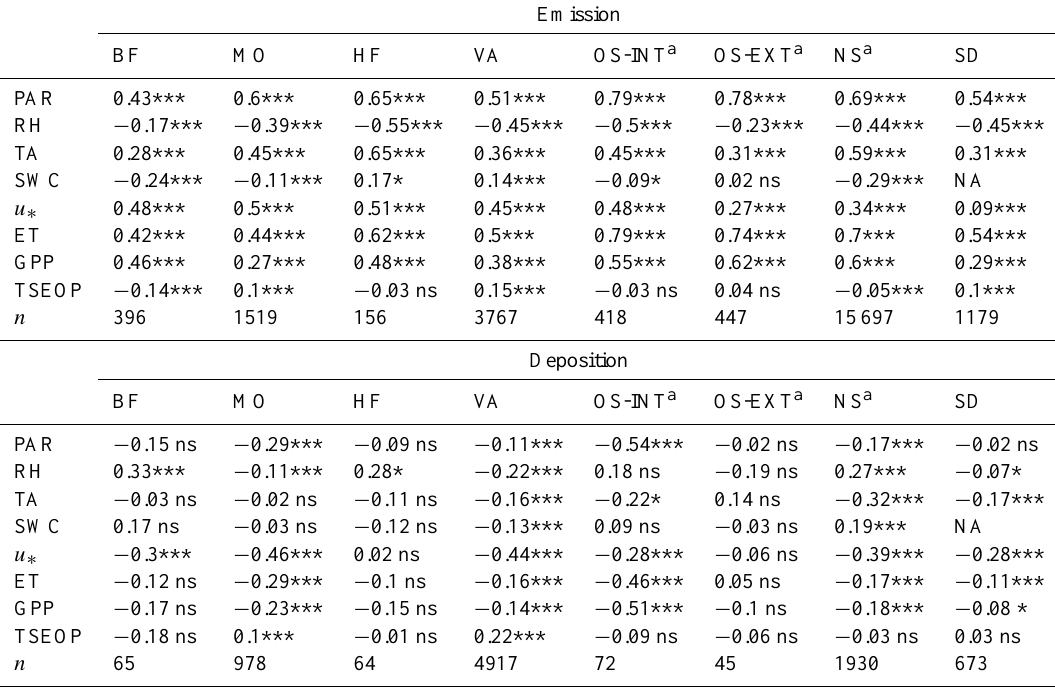
Table 3. Pearson correlation coefficients of multiple linear regressions of half-hourly methanol emission and deposition fluxes as a function of several independent variables (PAR: photosynthetic photon flux density; RH: relative air humidity; TA: air temperature; SWC soil water content; u ∗ : friction velocity; ET: evapotranspiration; GPP: gross primary productivity; TSEOP: time since end of precipitation; n : number of